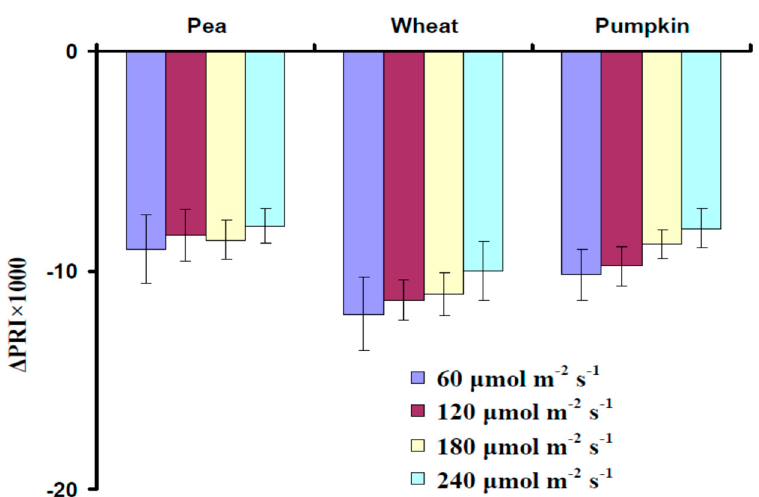
Figure 5. Magnitudes of AL-induced changes in the photochemical reflectance index ( ∆ PRI), which were measured at different intensities of GYL pulse in pea, wheat, and pumpkin ( n = 6). ∆ PRI was calculated as the difference between the PRI after 5 min of illumination by the AL (maximum intensity at 630 nm, 1599 µ mol m − 2 s − 1 ) and initial PRI (without the AL). PRI was calculated as R 531 − R 570 . R 531(570) was calculated as R 531(570) Averaged – R 531(570 )BG . R 531(570) BG is the absolute intensity of the reflected light at 531 (570) nm before the GYL pulse and R 531(570) Averaged is the averaging of the absolute intensities of the reflected light at 531 (570) nm during the GYL pulse.